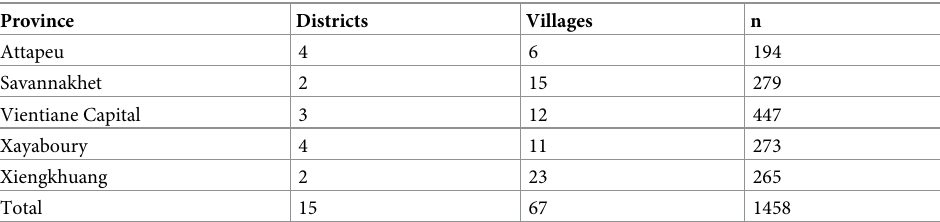
Table 1. Distribution of goats tested throughout Lao